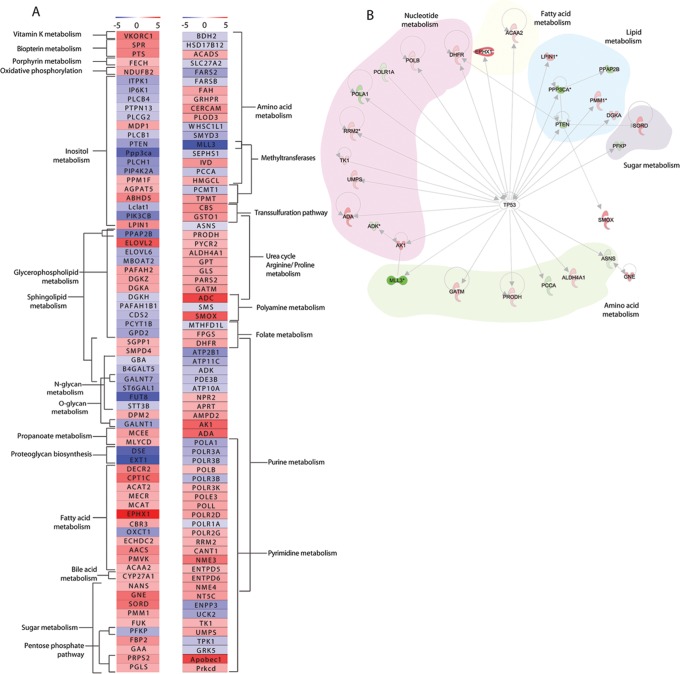
Differentially regulated metabolic enzymes.(A) Heatmap indicating metabolic enzymes obtained from Cytoscape metabolic signaling network (Fig. S4, highlighted in blue; Table S2), differentially regulated after 8 h of cisplatin treatment and enriched metabolic pathways within the dataset. (B) Regulation of metabolic enzymes by the transcription factor p53 obtained with Ingenuity pathway analysis.